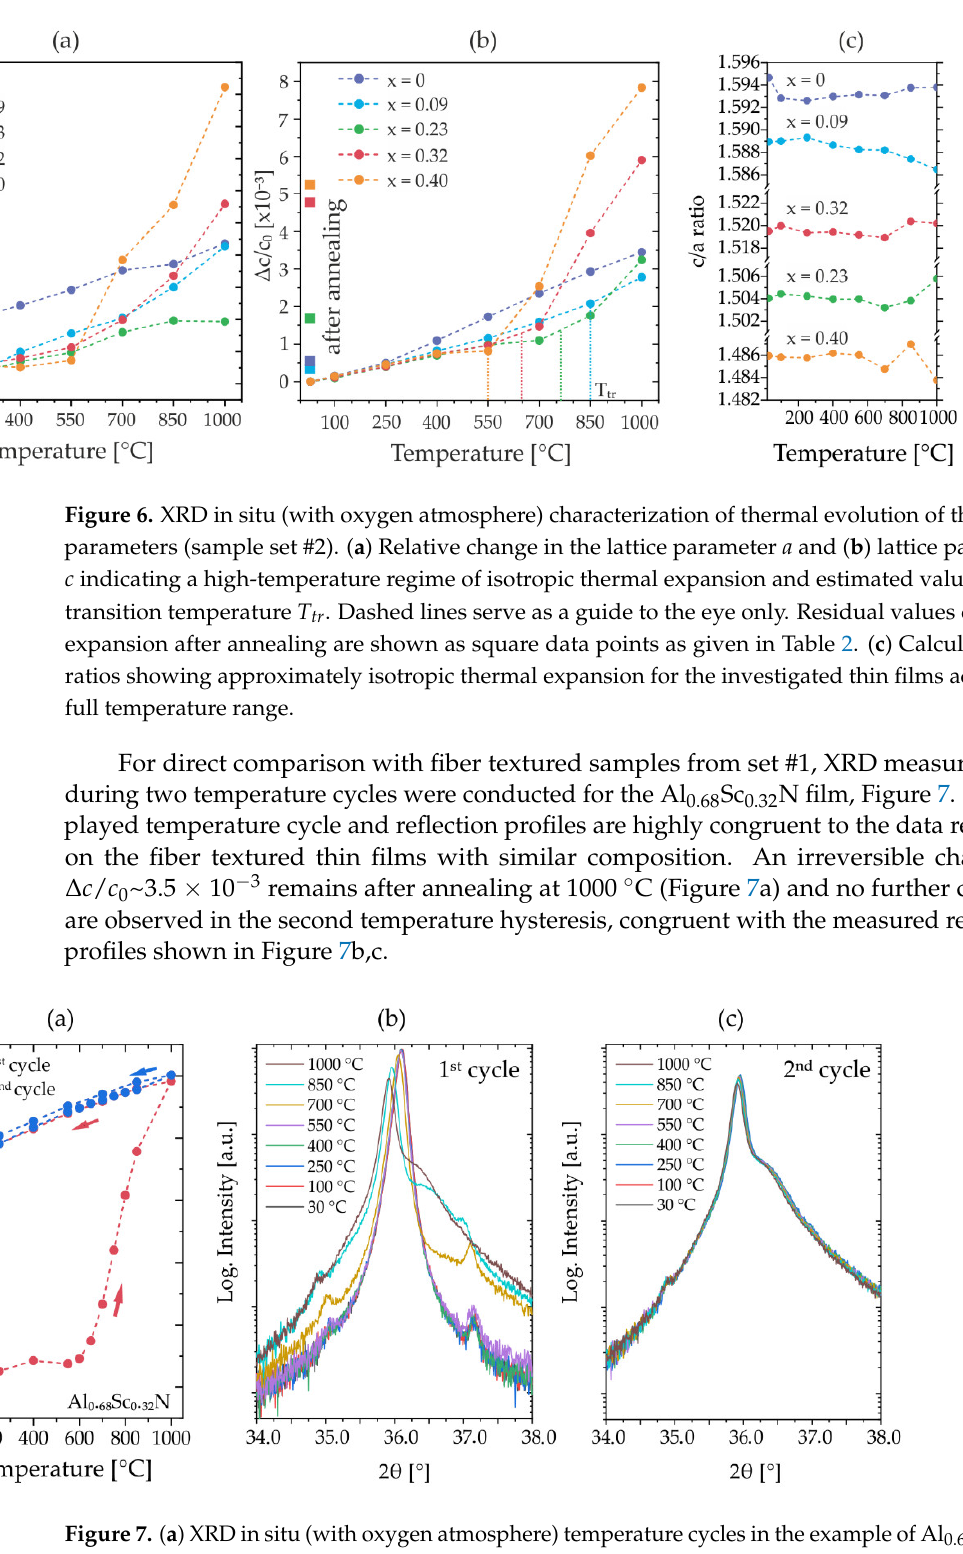
Figure 7. ( a ) XRD in situ (with oxygen atmosphere) temperature cycles in the example of Al 0.68 Sc 0.32 N (sample set #2). ( b ) Evolution of 0002-reflection profile in the first annealing cycle. ( c ) 2 θ / θ -scan: Evolution of 0002-reflection profile in the second annealing